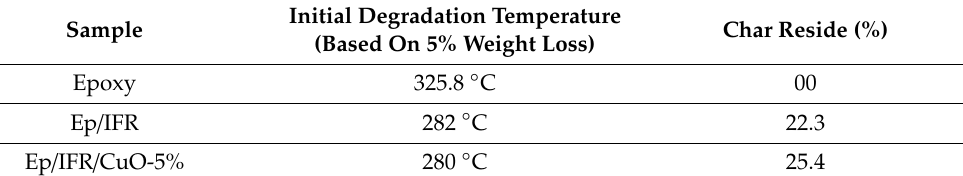
Table 4. Thermo-gravimetric results of the